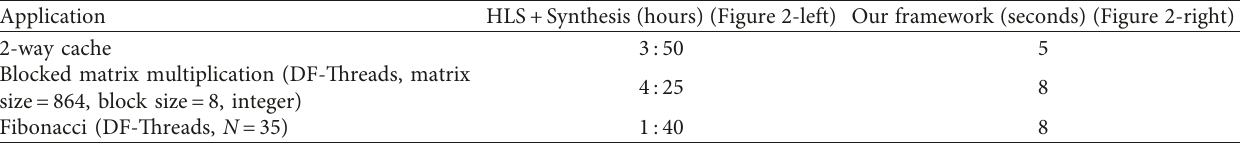
Table 3: Comparison of different total DSE time of the classical design workflow for FPGAs (Figure 2-left) and our proposed methodology (Figure 2-right).